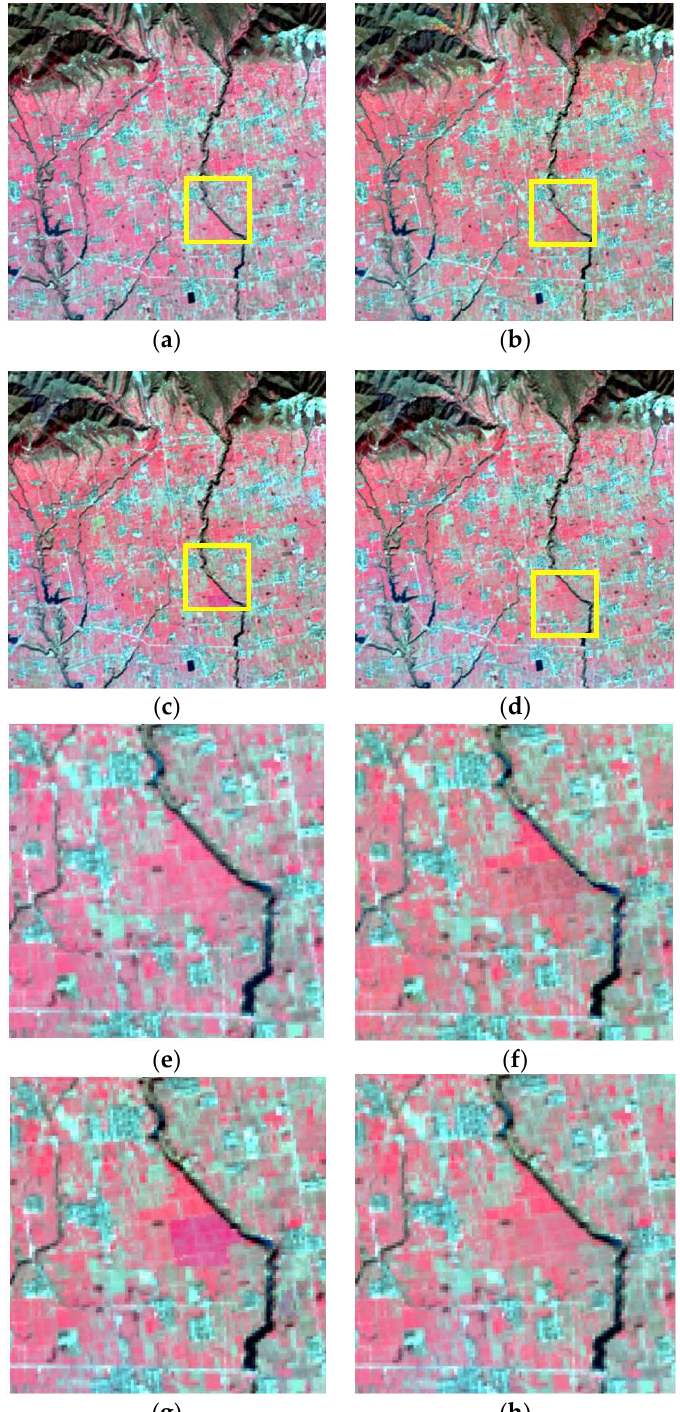
Figure 12. The fusion results of study area 1. ( a ) Actual Landsat image, ( b ) STARFM, ( c ) ESTARFM, ( d ) I-ESTARFM, ( e ) Actual Landsat image (highlight region), ( f ) STARFM (highlight region), ( g ) ESTARFM (highlight region), ( h ) I-ESTARFM (highlight region).